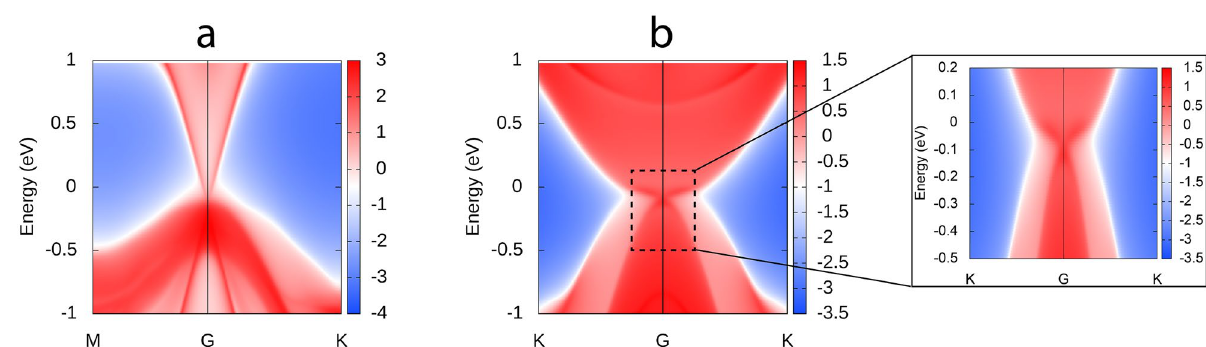
Figure 7. Computational surface and edge states of the ( a ) Bulk and ( b ) Low dimensional [111] phase of HH LiMgAs respectively (alongside zoomed image of the edge states in a small energy Z 2 analysis, surface and edge states. Figure 7a,b represents, the surface and edge states at the critical pressure which is obtained computationally using, iterative Green’s function calculation for the bulk and low-